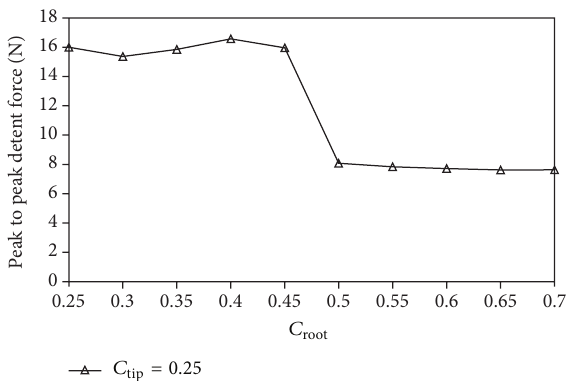
Figure 5: Peak to peak value of detent force with respect to 𝑐